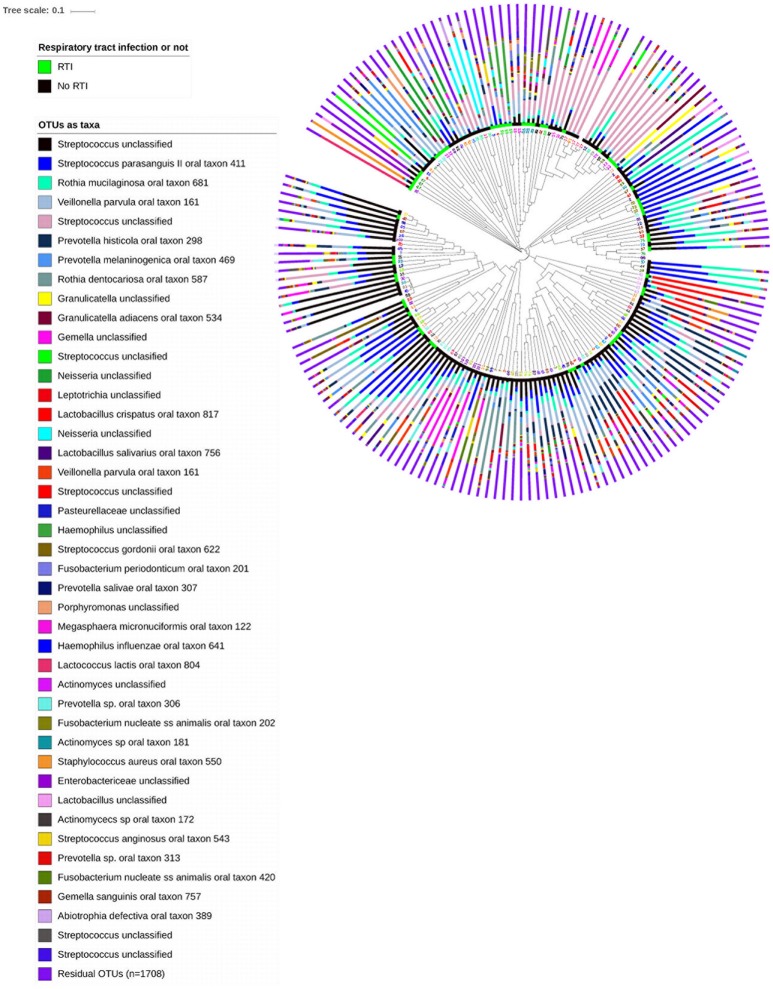
Unweighted hierarchical clustering analysis, using UPGMA algorithm (unweighted pair group method with arithmetic mean), of 167 oropharyngeal samples from 53 patients admitted to hospital with lower limb fracture. Adjacent to the branch ends, samples from patients who subsequently developed respiratory tract infection are highlighted in green, and those who did not were highlighted by the black bar. Stacked bar charts show the relative abundance of the 43 highest ranked OTUs (85% of the data) and the summed relative abundances of residual OTUs. Patient ID numbers are highlighted adjacent to dendrogram branch ends, and demonstrate similarity between samples from individuals.